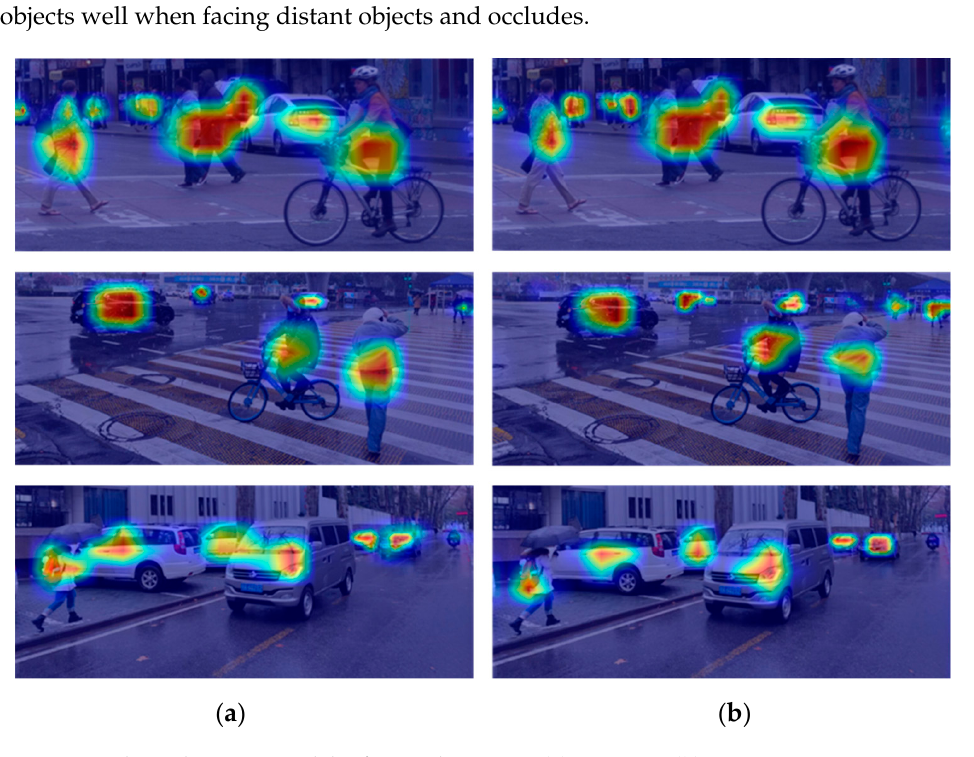
( b ) Figure 17. Object detection results of KITTI dataset: ( a ) YOLOv4; ( b ) VV-YOLO.